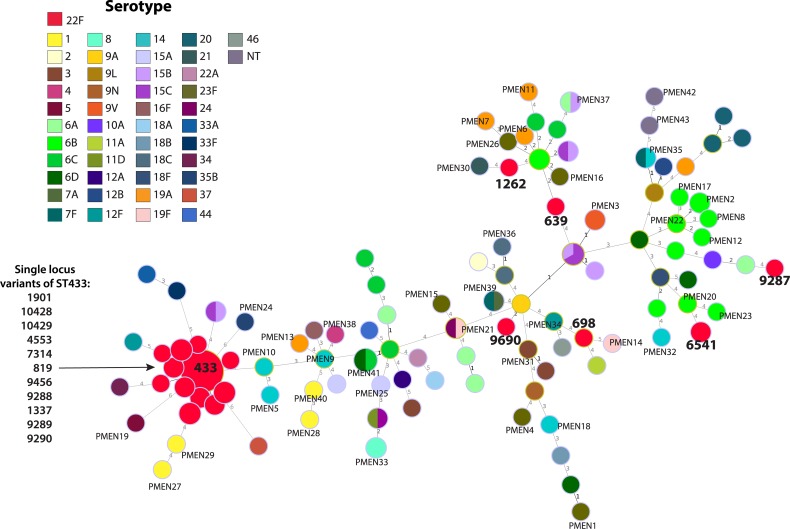
Multi-locus sequence type (MLST) comparison of the genetic relatedness of Streptococcus pneumoniae serotype 22F.Node colour indicates serotype and diameters are proportional to the number of isolates. Major MLST types of serotype 22F isolates are displayed in bold text and Pneumococcal Molecular Epidemiology Network (PMEN) clones are indicated. Branch labels are the number of allelic variations between sequence types; branch lengths are not to scale.